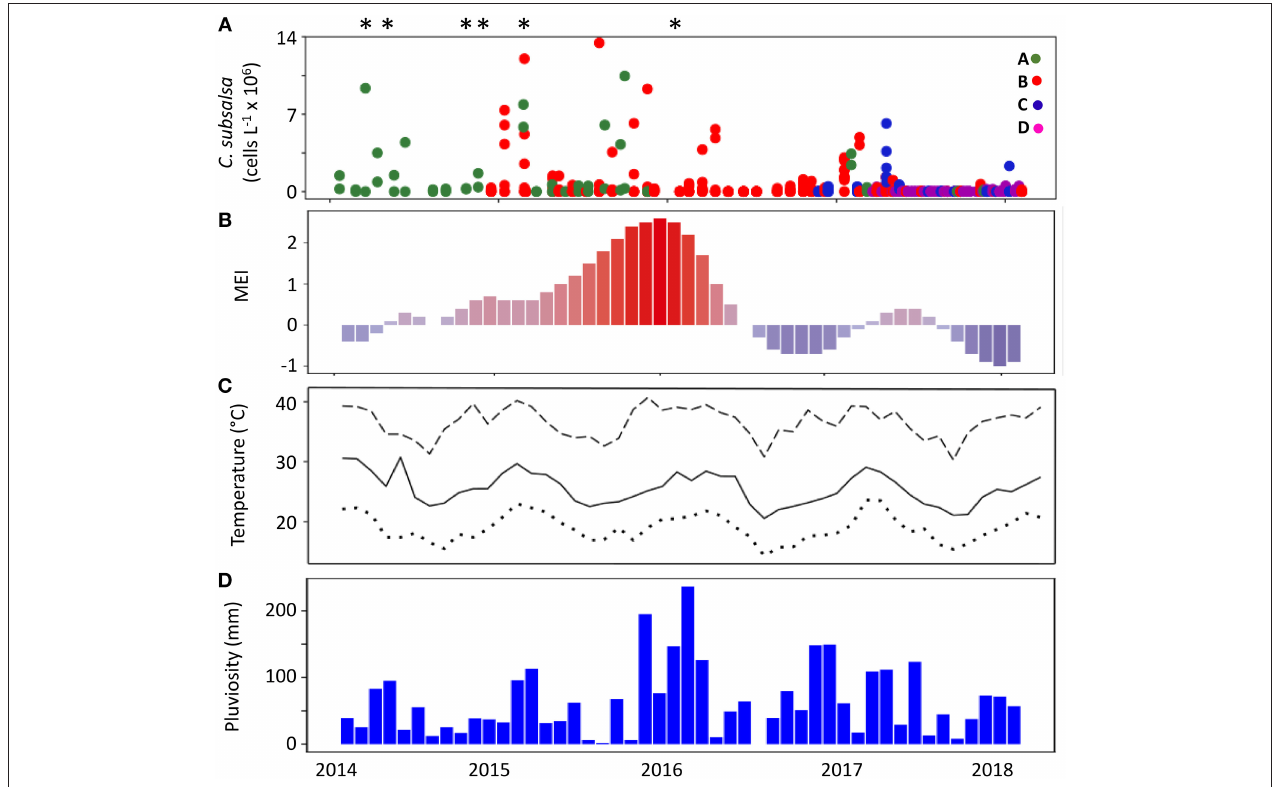
FIGURE 3 | Concentration of C. subsalsa cells in Guanabara Bay and climatological parameters over a 4-year period (February, 2014 to January, 2018). (A) C. subsalsa cell concentration detected in samples from four monitoring series ( A–D , see map in Figure 1 for details), *Fish-kills in Guanabara Bay reported in the local media; (B) Multivariate El Niño Index; (C) average (solid line), maximum (dashed line), and minimum (dotted line) monthly air temperature; (D) accumulated monthly pluviosity.